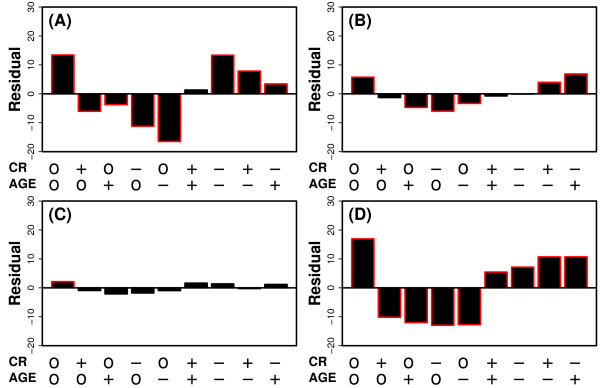
Relationship between caloric restriction and aging in liver, heart, muscle and the central nervous system. Association between differential expression signatures. The association between CR and aging was evaluated for the (A) liver, (B) heart, (C) muscle and (D) central nervous system (hippocampus + cortex). For each tissue, a differential expression signature was constructed corresponding to the effects of CR, and another signature was constructed corresponding to the effects of aging. Both signatures were based upon 3 or more experiments (see Figure 8 legend). CR and aging signatures were cross-tabulated, to place component genes into 9 separate categories, depending upon whether genes were increased by CR and/or aging (+), decreased by CR and/or aging (-), or whether CR and/or aging had no significant effect on gene expression (o). For each category, bars represent the adjusted Pearson residual (see Methods) (94). The absolute value of this quantity reflects the degree to which gene counts differ from what is expected based upon a random association between the CR and aging differential expression signatures. Positive residuals indicate that more genes belong to that category than expected by chance, given a random association between the effects of CR and aging. Negative residuals indicate that fewer genes belong to that category than expected by chance, given a random association between the effects of CR and aging. The adjusted Pearson residuals follow a standard normal distribution, with residuals larger than 3 in absolute value suggestive of significant, non-random associations between the effects of CR and aging [94]. The bars outlined in red indicate a significantly large or small residual (P < 0.05).